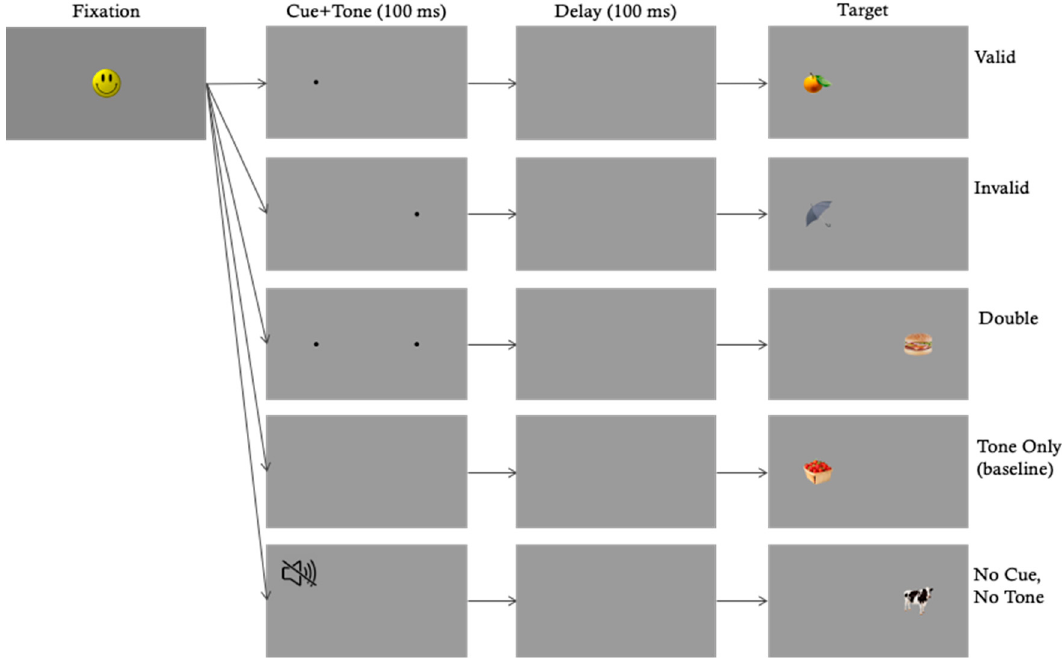
Figure 1. Experimental and control conditions from the Infant Orienting with Attention (IOWA) Task [1].